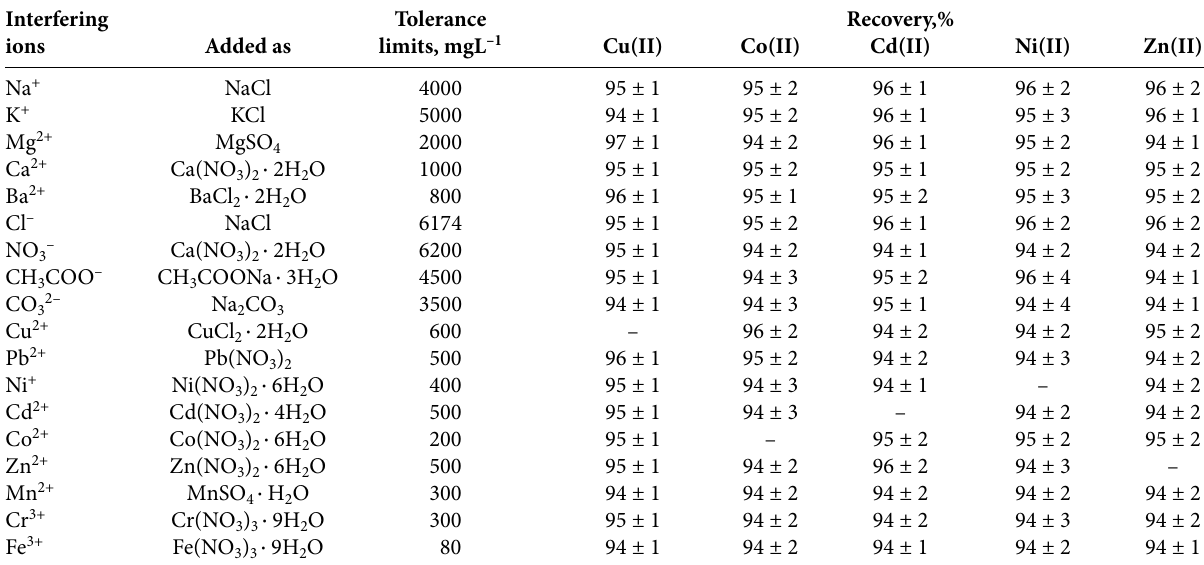
Table 2. Effect of interfering ions on the recoveries of the analyte ions (n = 3) Interfering Tolerance Recovery,% ions Added as limits, mgL –1 Cu(II) Co(II)